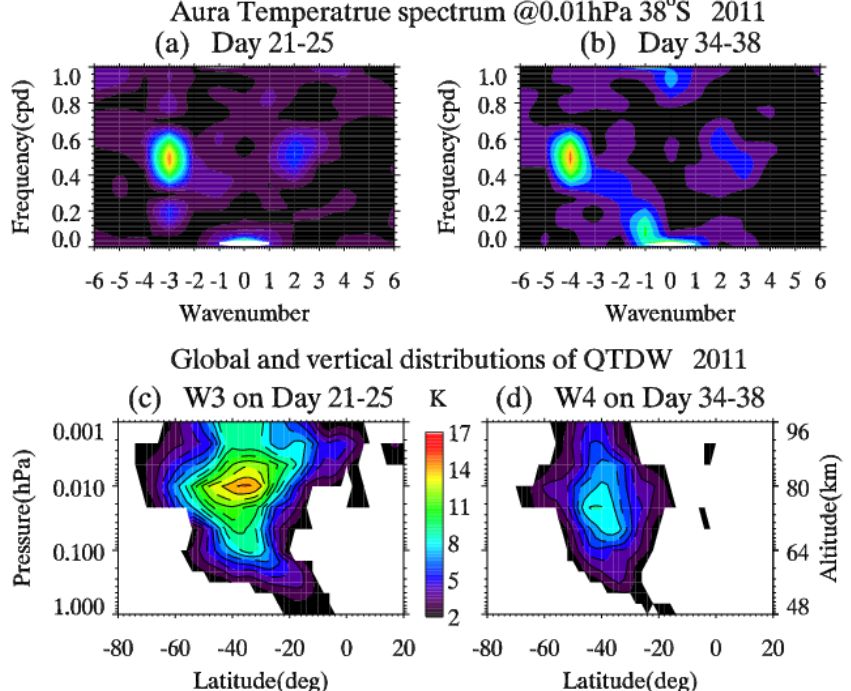
Figure 1. Dominant Aura temperature wave modes at 0.01 hPa and 38° S during ( a ) days 21 − 25 and ( b ) days 34 − 38 in 2011. A negative (positive) wavenumber means westward (eastward). W3 and W4 are the dominant wave modes in Figure 1a,b, respectively. The vertical and global structures of ( c ) W3 and ( d ) W4 are obtained with observations taken during the same period as in ( a , b ). The contours in ( c , d ) start from 2 K with intervals of 1 K.